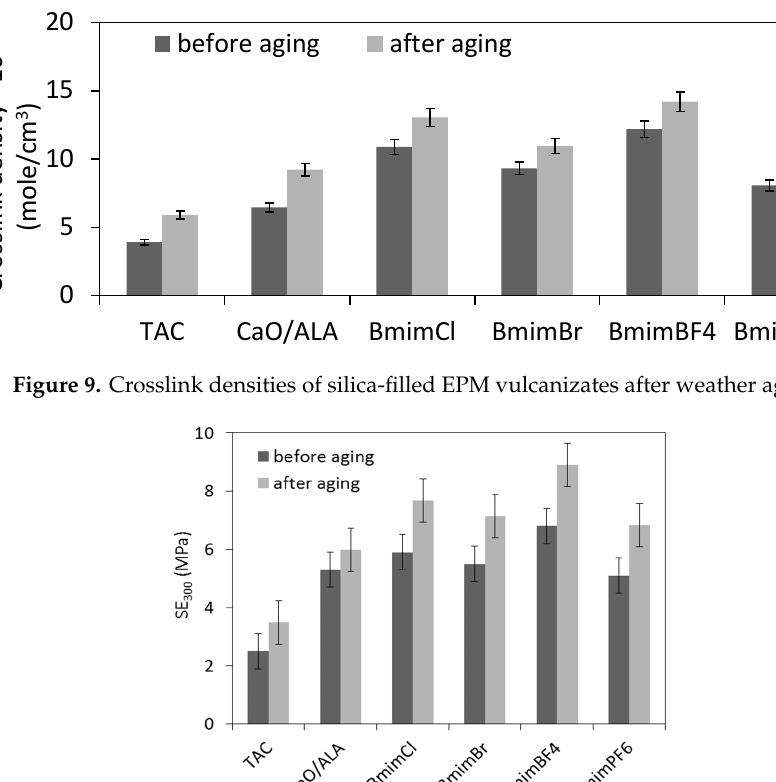
Figure 10. Modulus at 300% relative elongation of silica-filled EPM vulcanizates after weather aging.